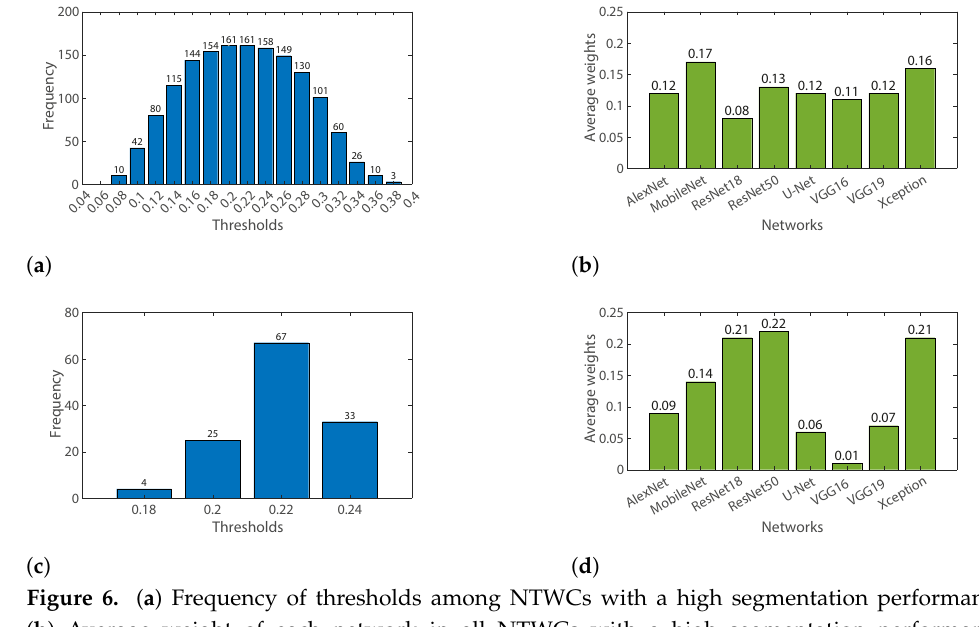
Figure 6. ( a ) Frequency of thresholds among NTWCs with a high segmentation performance, ( b ) Average weight of each network in all NTWCs with a high segmentation performance, ( c ) Frequency of thresholds among NTWCs with a high margin assessment performance, ( d ) Average weight of each network in all NTWCs with a high margin assessment